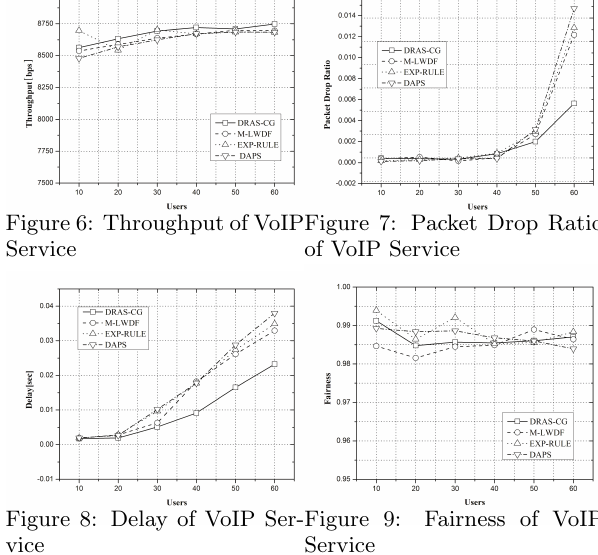
Figure 9: Fairness of VoIP